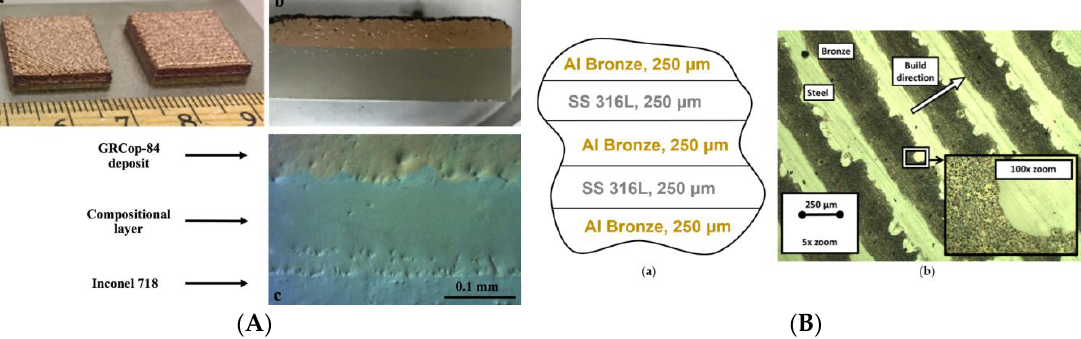
Figure 1. Optical image of the compositional interface: ( A ) as fabricated bimetallic structures of Inconel 718 and GRCop-84 [12]; ( B ) the resulting graded structure from SS316L—Al Bronze [13] (Reprinted with permission from Ref. [13] Elsevier 2021).